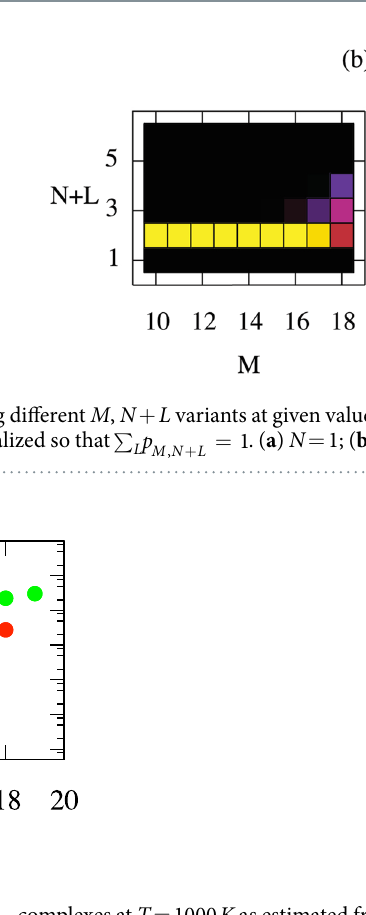
Fig. 4, where the color at a given M , N + L coordinate encodes the probability of observing that specific variant at the corresponding value of the helium content M . These probabilities are normalized so that ∑ = results show that the equilibrium value of L increases with increasing M . This is expected, given the sharp increase in nucleation rates with increasing M . For N = 1, multiple variants start to coexist around M = 12 (two or more values of N + L have significant occurrence probabilities). Coexistence is usually limited to 2 variants, but in some